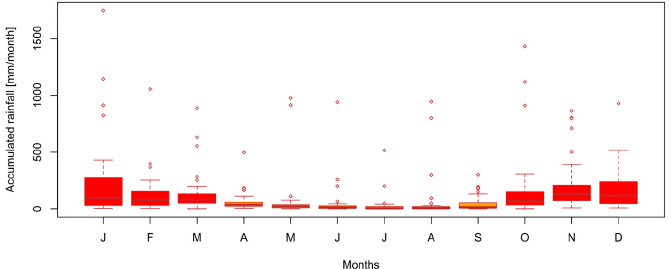
Figure 3. The graphic shows asymmetric precipitation distribution and outliers. Monthly rainfall of forty-one years on the island of Tenerife (1976 to 2016). The non-rainy months are in orange and the rainy ones are in red.